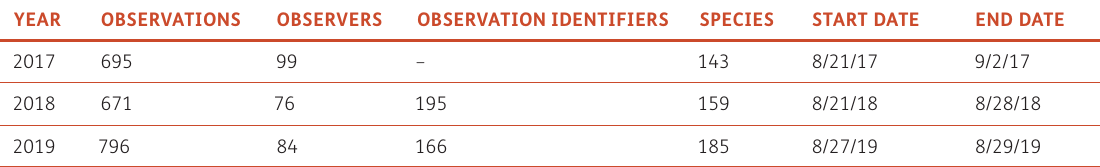
Table 2 Project statistics from iNaturalist project page.